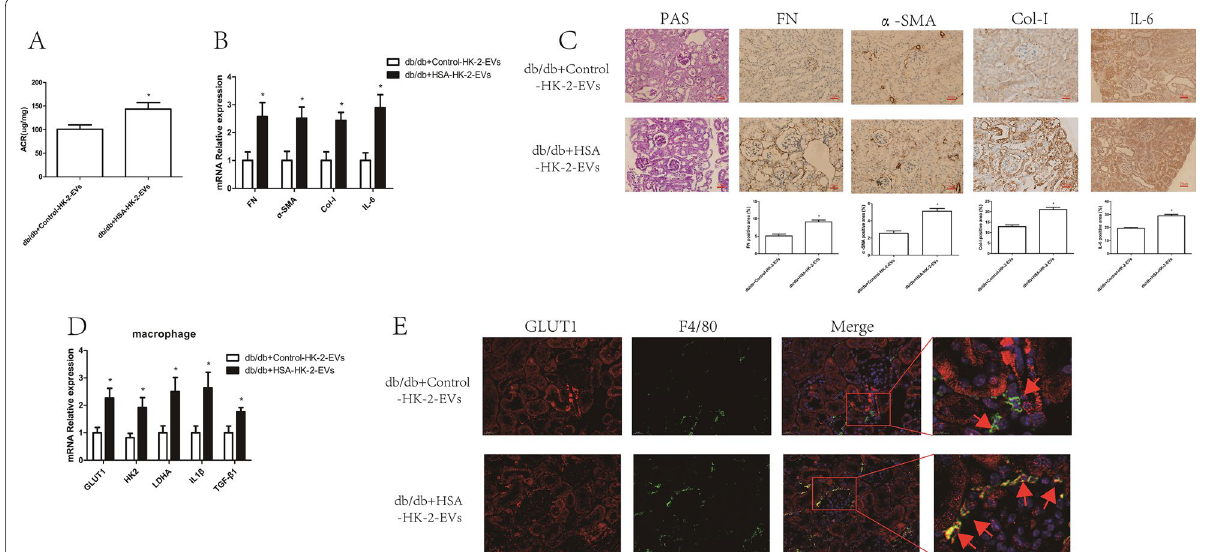
Fig. 4 HSA-treated tubular epithelial cell-derived EVs promoted macrophage glycolysis in vivo. db/db mice were injected with Control-HK-2-EVs and HSA-HK-2-EVs via the caudal vein: A urinary albumin creatinine ratios (ACRs) of db/db (n 5) mice; B mRNA expression of FN, α-SMA, Col-I and IL-6 in the kidney cortexes of db/db = (n 5) mice; C PAS staining and immunostaining of FN, α-SMA, Col-I and IL-6 (original magnification = db